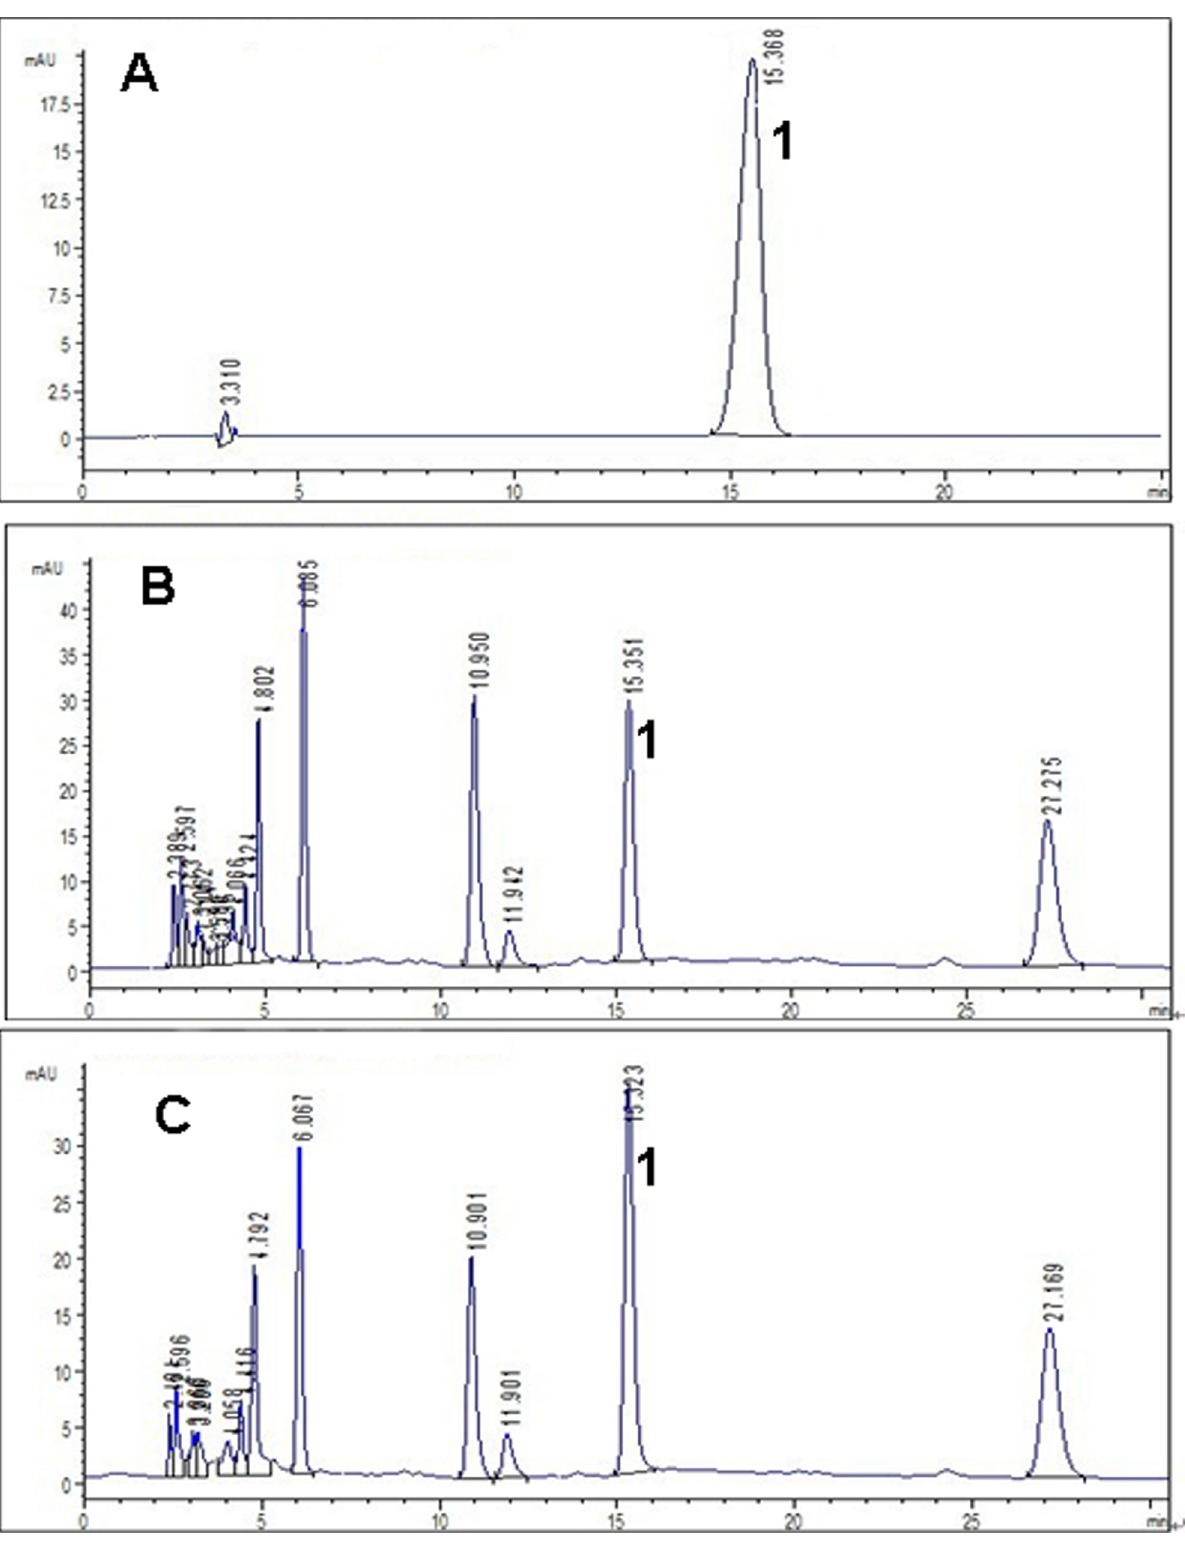
Figure 4. HPLC chromatograms of adenosine standard, samples of the root under ambient [CO 2 ] and elevated [CO 2 ]. Peak # 1 is adenosine commercial standard. A: Representative chromatogram for adenosine standard (The contents of adenosine were 0.0272 mg/ml. Five concentrations of adenosine standard have been measured for the standard curve: 0.0068, 0.0136, 0.0272, 0.0544 and 0.068 mg/ml). B: Root sample chromatogram under ambient [CO 2 ](one out of three replicates). C: Root sample chromatogram under elevated [CO 2 ] (one out of three replicates).